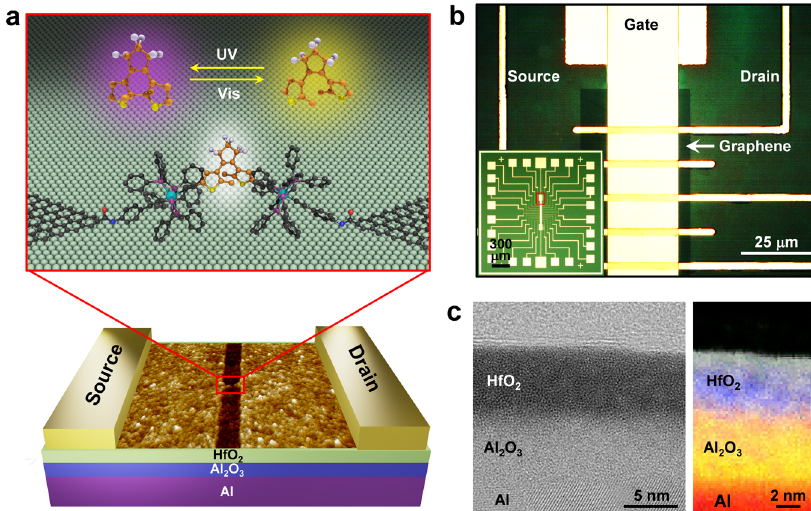
Fig. 1 Device diagrams of a graphene-Ru-DAE-graphene single-molecule FET. a Schematic representation of the device structure. Bottom: Atomic force microscopic image of nanogapped graphene point contacts with the bottom gate. Top: Schematic of the device center that highlights the reversible isomerisation of the DAE unit between ring-open and ring-closed forms that are triggered by optical stimuli. b Optical images of a graphene-Ru-DAE- graphene single-molecule FET array with a common bottom gate based on a HfO 2 /Al 2 O 3 /Al multilayer. The inset shows the complete pattern, where the central region marked by a red circle is enlarged for clarity. c Left: Cross-sectional scanning transmission electron microscope (STEM) image of the HfO 2 / Al 2 O 3 /Al multilayer structure. The sample was prepared using a focused ion beam and imaged using the STEM (200 kV). Right: Analyses of the elemental compositions of the dielectric layer, which includes hafnium, oxygen, and aluminum, performed using an energy-dispersive X-ray spectroscopy system. These characterizations show that the thickness of both the Al 2 O 3 and HfO 2 layers is ~5